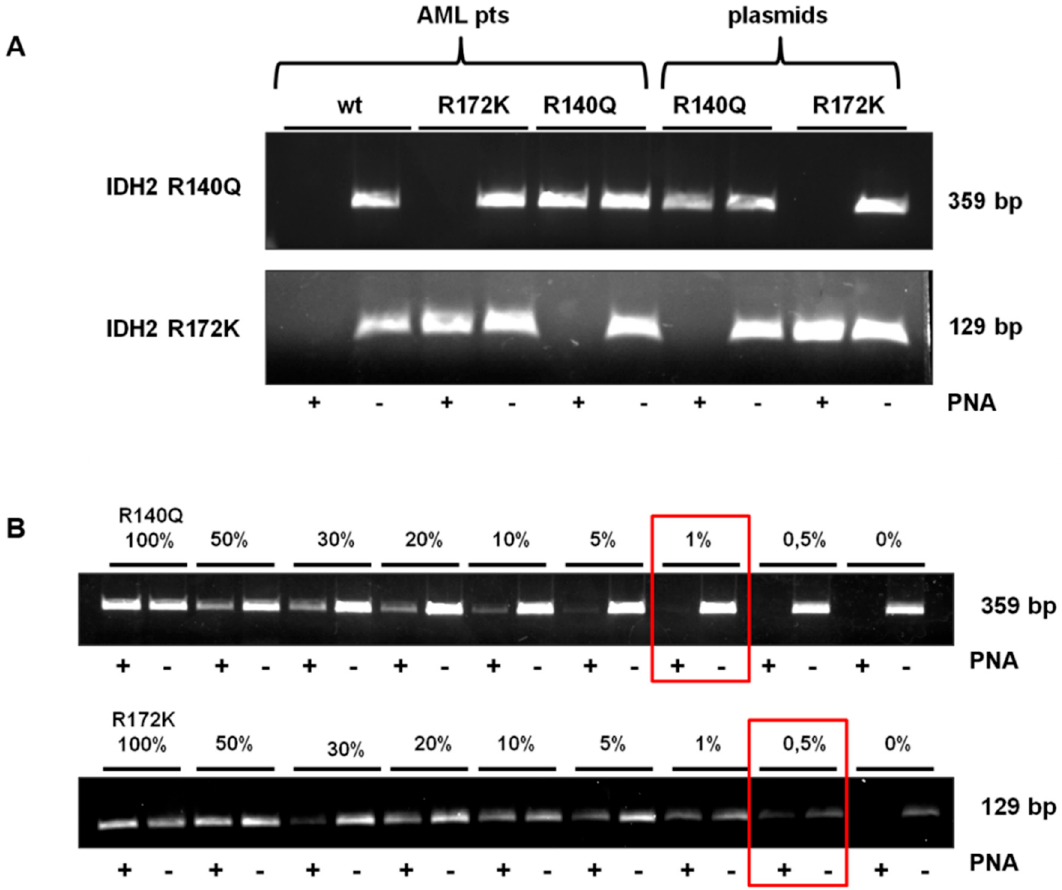
Figure 2. Electrophoretic runs of PCR reactions: 10 μ L of each amplicon were loaded on 2% Agarose-TBE 1× gel with 5 μ g/mL EtBr and run at 120 V for 30 min. PNA-PCR clamping for IDH2 R140Q and